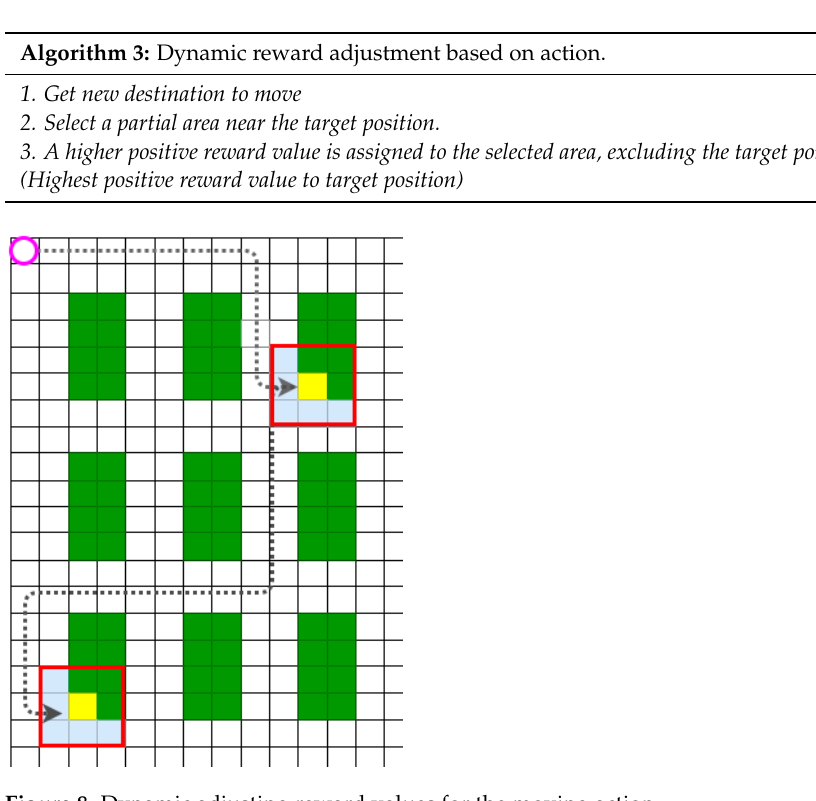
Algorithm 3: Dynamic reward adjustment based on action.